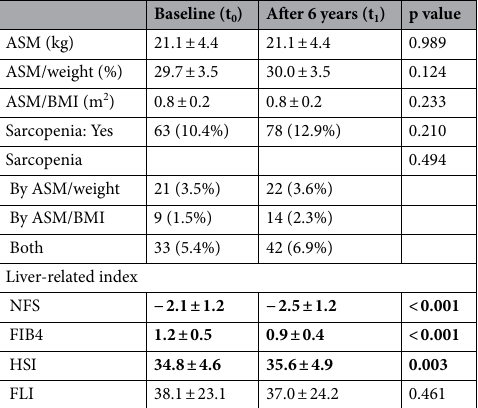
Table 2. Changes in muscle mass and sarcopenia status for 6 years (bold: p value < 0.05). ASM Appendicular skeletal muscle mass, BMI Body mass index, NFS NAFLD Fibrosis Score, FIB4 Fibrosis-4 Index for Liver Fibrosis, HIS Hepatic Steatosis Index, FLI Fatty Liver